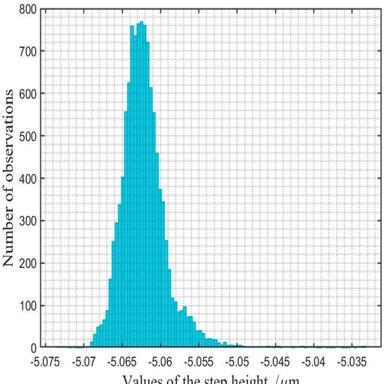
The distribution of the heights of subtracting the datum plane from the plane SB in Experiment 2.